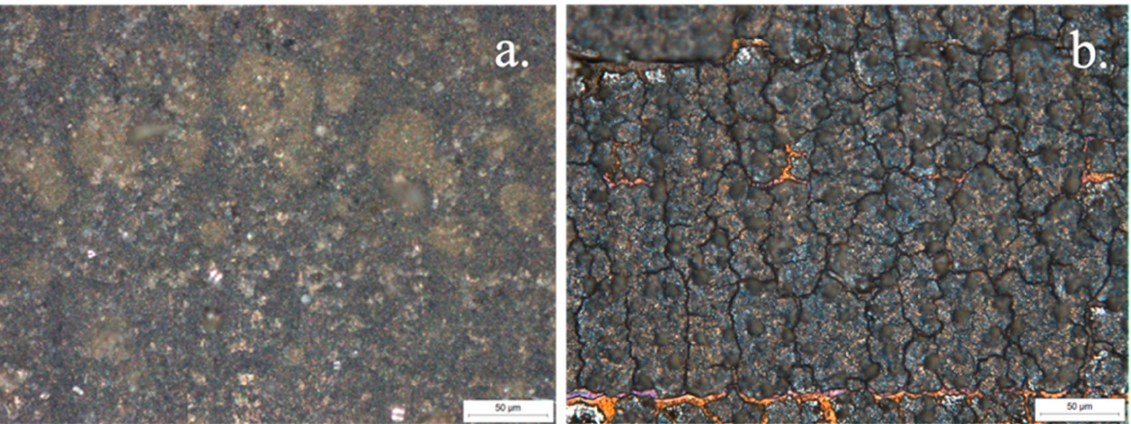
Table 2. Laser parameters experiments setting.